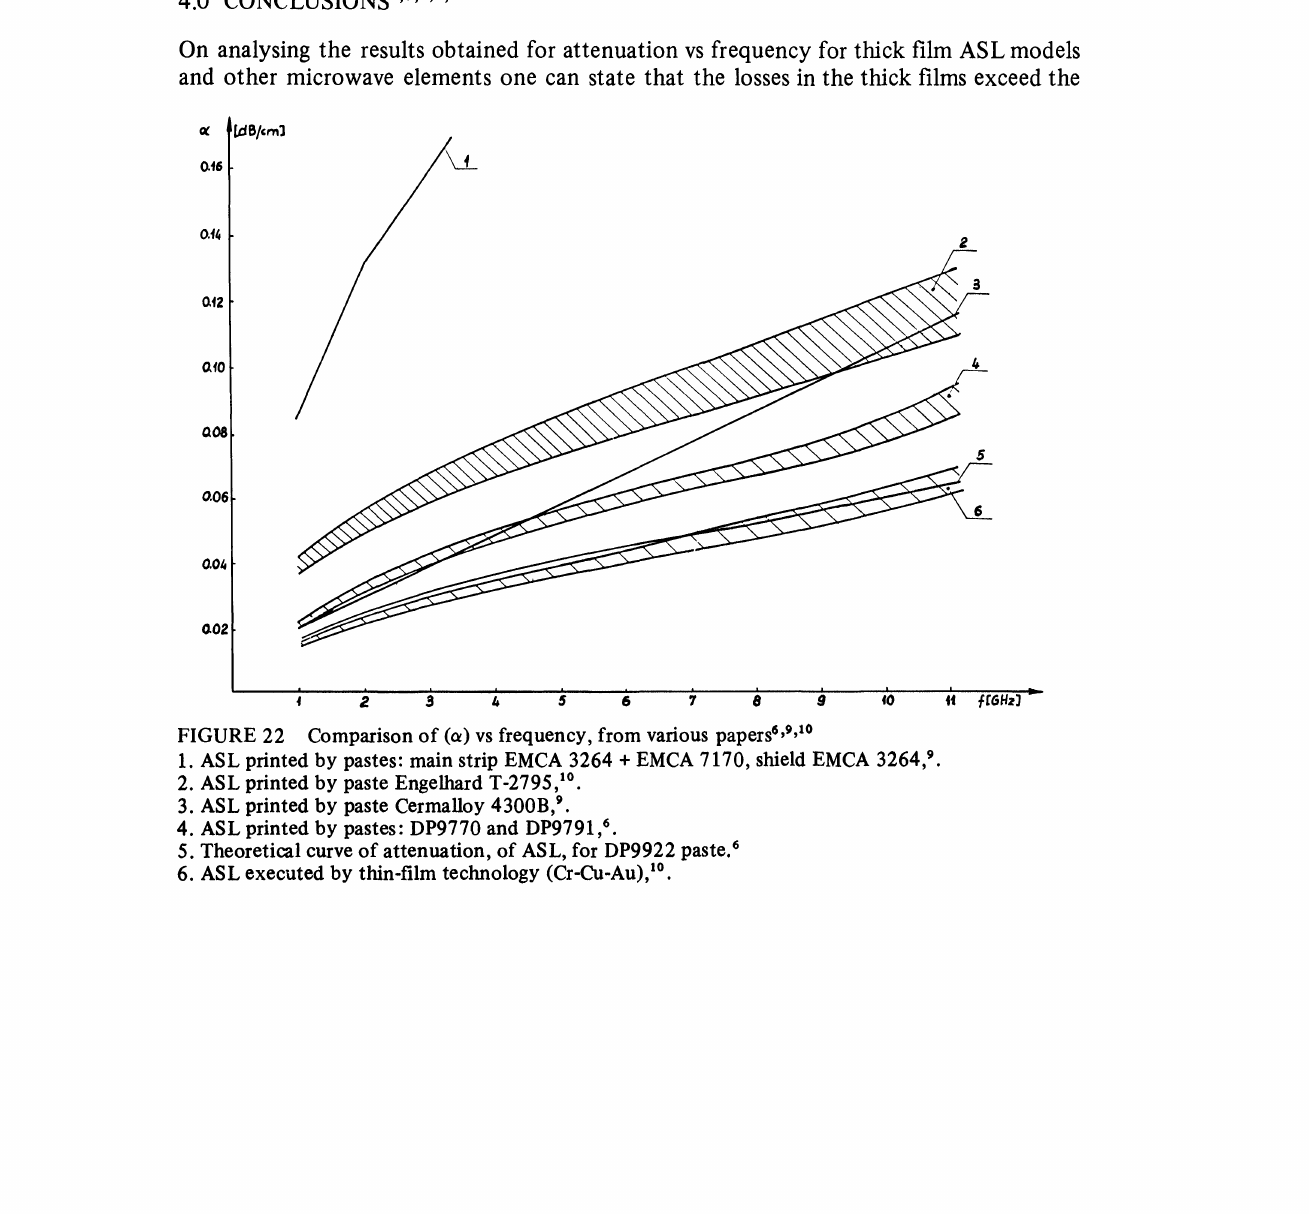
FIGURE 22 Comparison of (a) vs frequency, from various papers +,9’a 1. ASL printed by pastes: main strip EMCA 3264 + EMCA 7170, shield EMCA 3264, 9. 2. ASL printed by paste Engelhard T-2795,1. 3. ASL printed by paste Cermalloy 4300B, 9. 4. ASL printed by pastes: DP9770 and DP9791, +. 5. Theoretical curve of attenuation, of ASL, for DP9922 paste. 6. ASL executed by thin-film technology (Cr-Cu-Au),